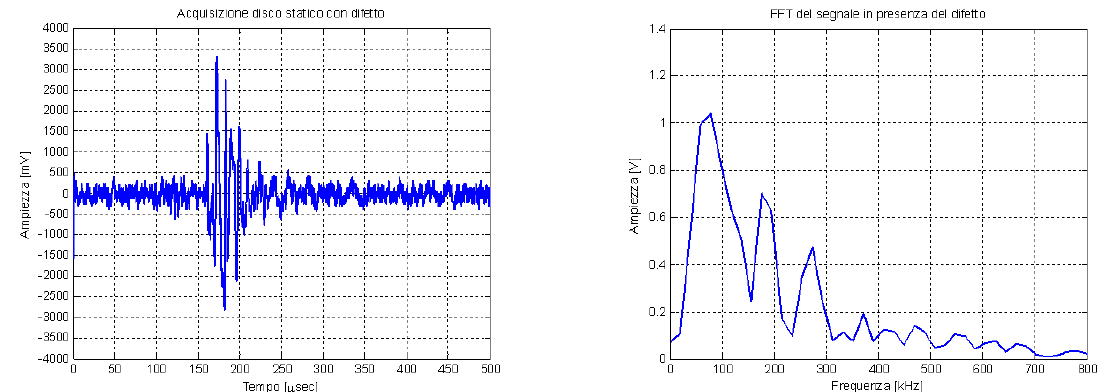
Figura 10: Segnale acquisito con disco fermo in presenza del difetto e relativa trasformata di Fourier. Figure 10: Signal acquired on the static disk, with defect, and its Fourier